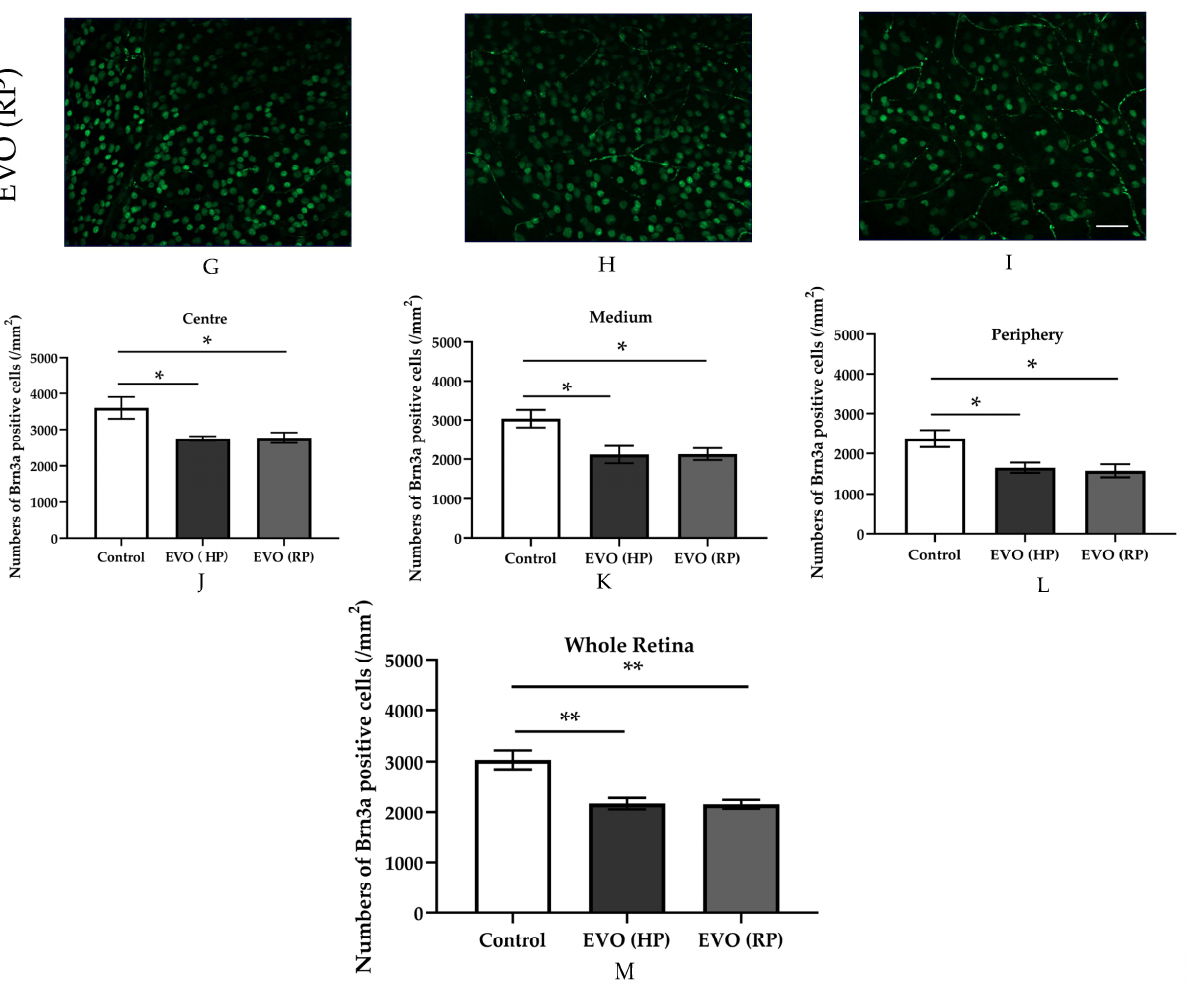
Figure 7. Immunostaining and RGC density in the retinal flatmounts. ( A , D , G , J ) show the RGC density in the center of the retina. ( B , E , H , K ) exhibit the RGC density in the middle of the retina. ( C , F , I , L ) show the RGC density in the periphery of the retina. ( M ) represents the mean RGC density in the whole retina, averaged from the three different parts. Control group refers to the sham group. Values are expressed as mean ± SEM. (* p < 0.05, ** p < 0.01; n = 5–6 per group, scale bar = 50 µ